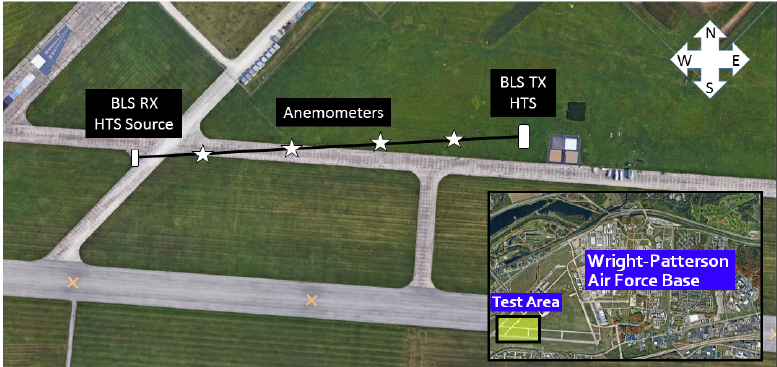
Figure 1. Overhead view of the sensing path. The four sonic anemometers are placed evenly 100 m apart along the path. The trailer on the western end of the path contains the boundary layer scintillometer receiver and the helium-neon lasers. The eastern trailer houses the HTS and the scintillometer